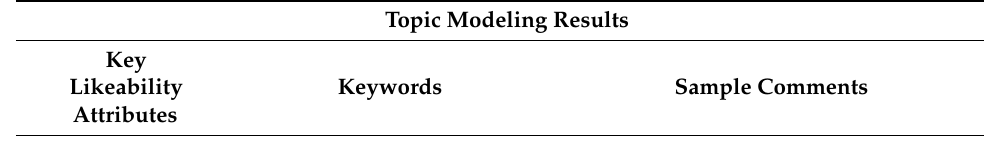
Table 3. Explored likeability